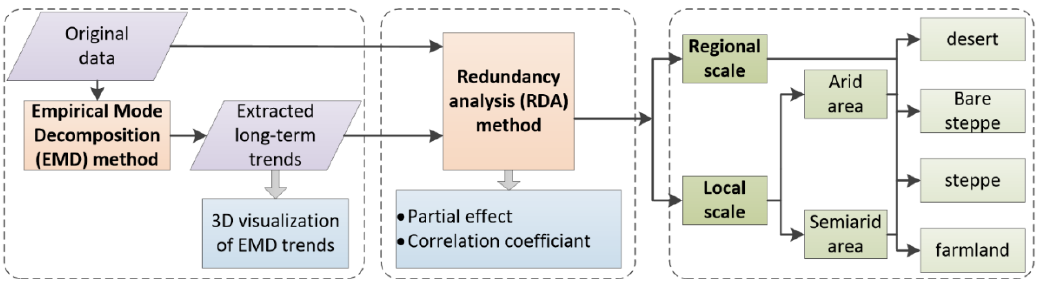
Figure 2. Flow chart of the synthesized research design and